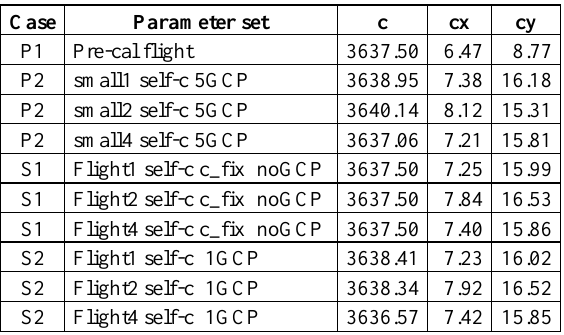
Table 3. Estimated principal distance and principal point position for the various cases. “small” refers to the small blocks of the “on-the-job” procedure